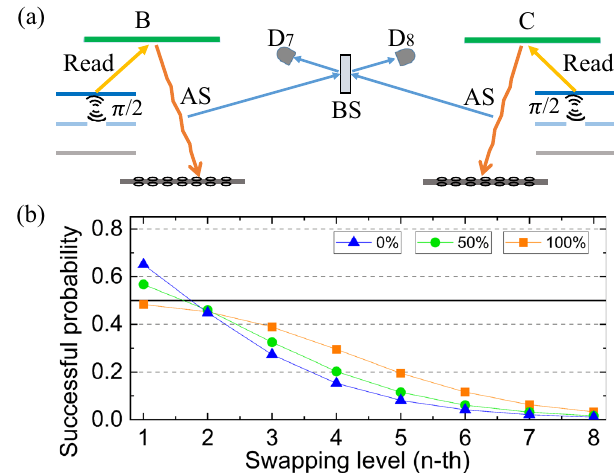
Fig. 3 Improving the entanglement connection process. a Scheme for optimization of the entanglement connection process. B and C are two adjacent nodes. Anti-Stokes, AS; beam splitter, BS; Detector, D. b The successful probabilities of the entanglement connection process as a function of the swapping levels (n) utilizing single-photon detectors with photon number resolution of 0 (triangle), 50% (dot), and 100% (square). Here we have assumed the total ef fi ciency η = 0.9 and excitation rate p c =